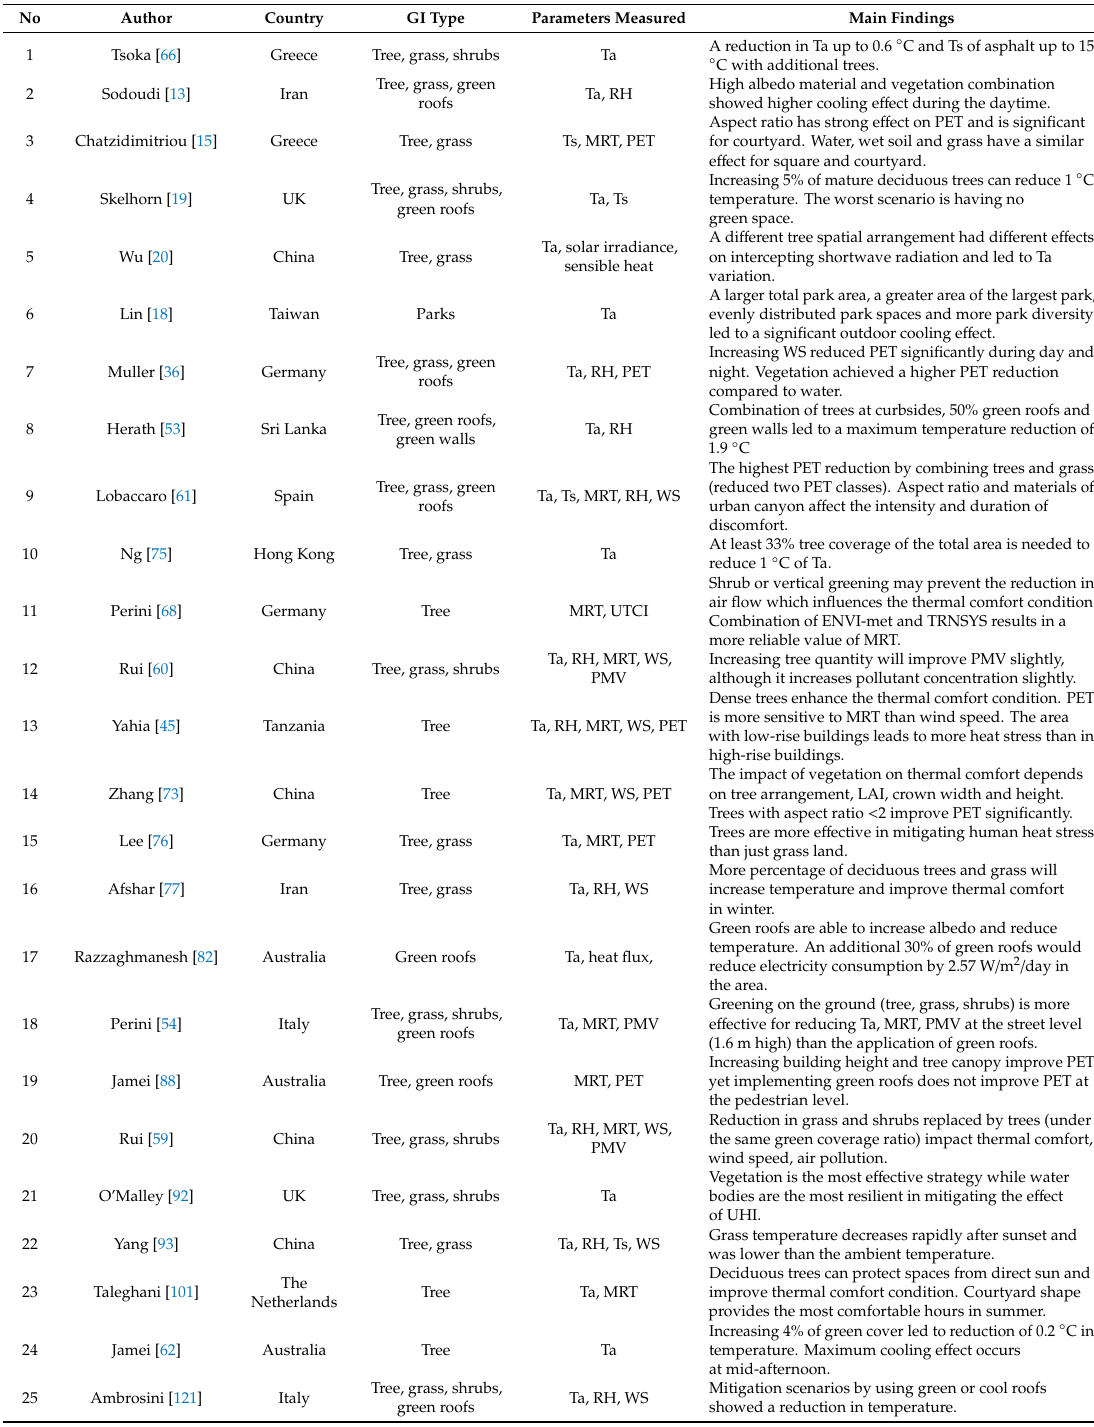
Table 3. A summary of the reviewed